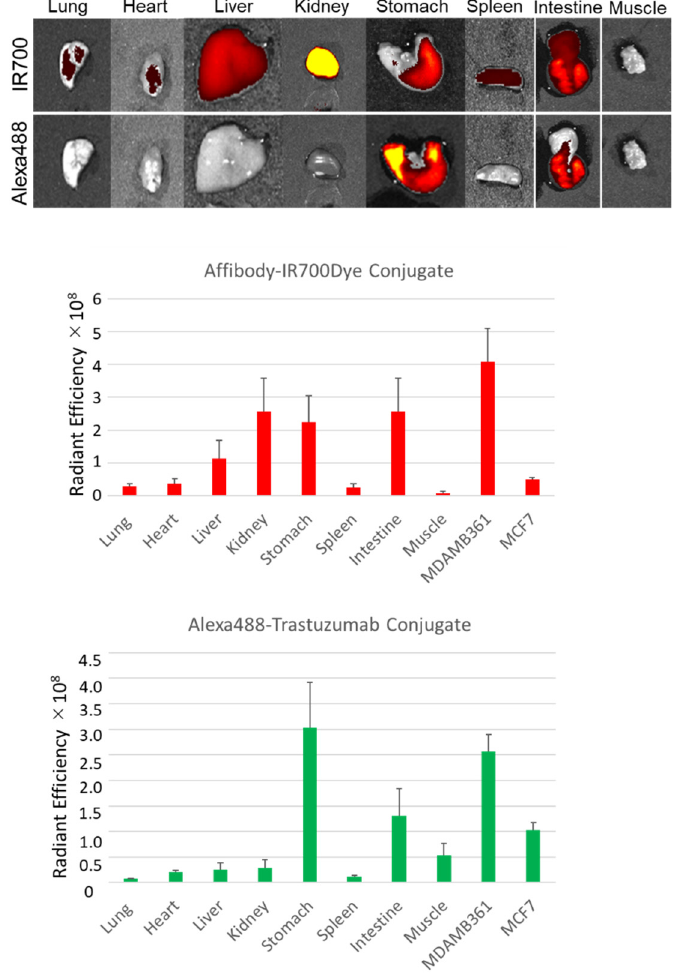
Figure 8. Fluorescence intensity from the individual organs of the mice injected with HER2 Af- fibody-IR700Dye conjugate and trastuzumab-Alexa488 conjugate. Data are presented as means ± SD ( n =